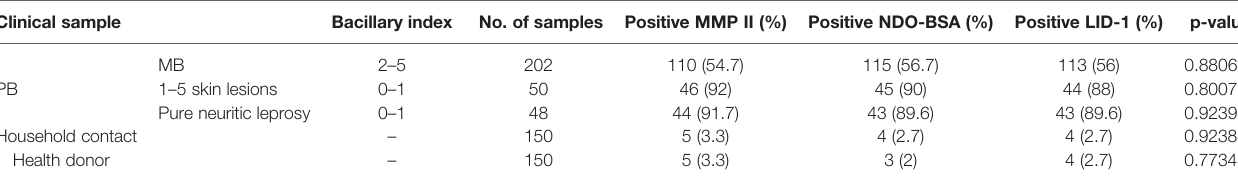
TABLE 2 | The overall positive rate of ELISPOT using three antigens of M. leprae in PBMC. Clinical sample Bacillary